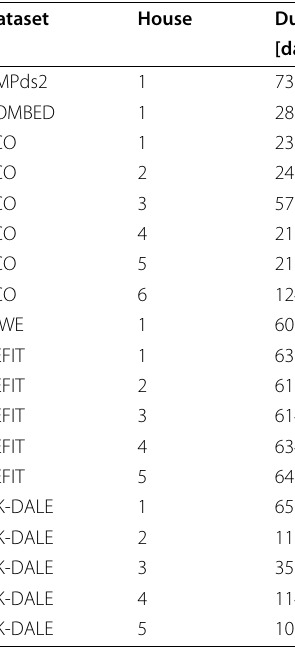
Table 1 Noise levels in NILM